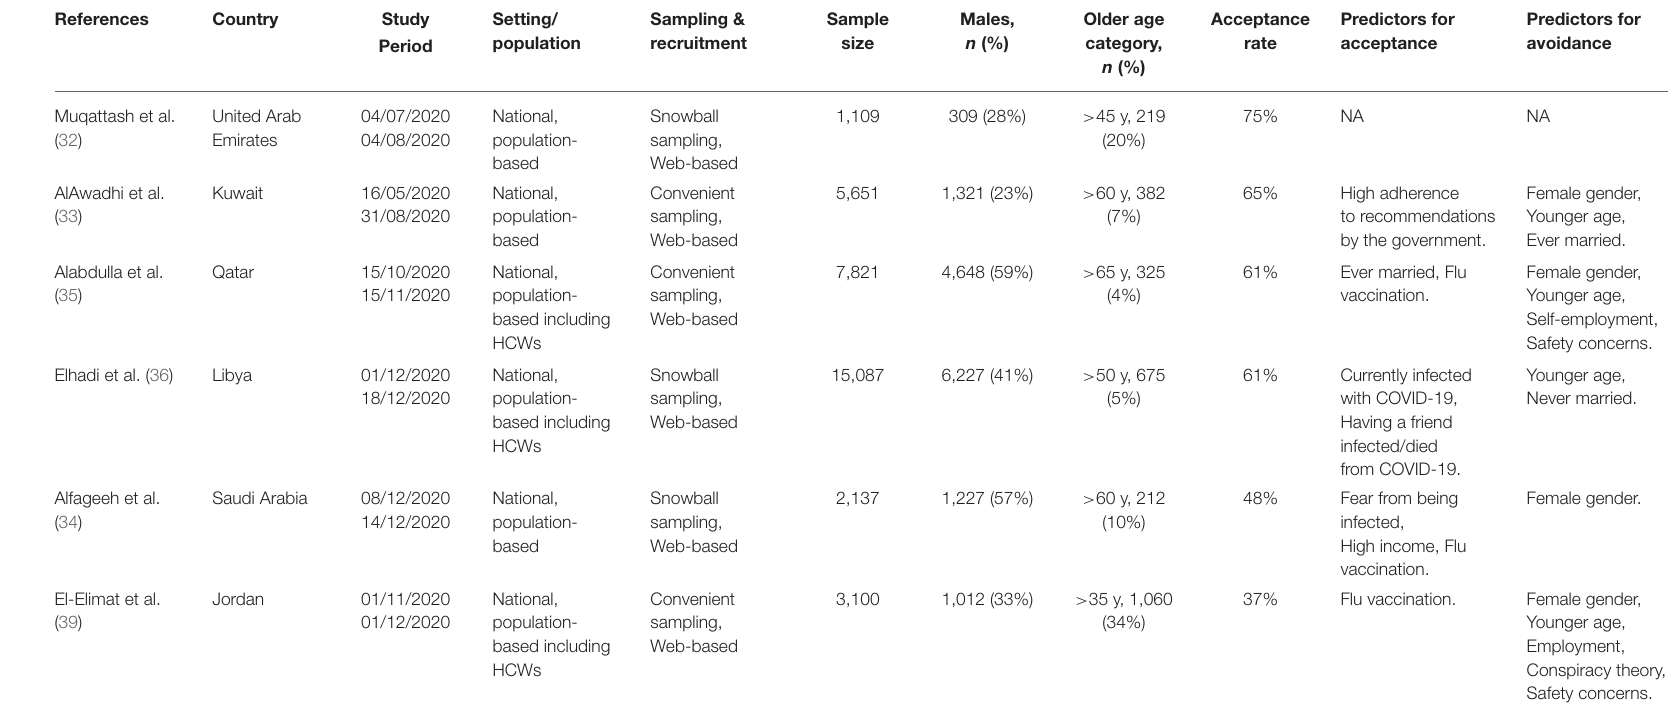
TABLE 4 | Characteristics of studies included from the MENA